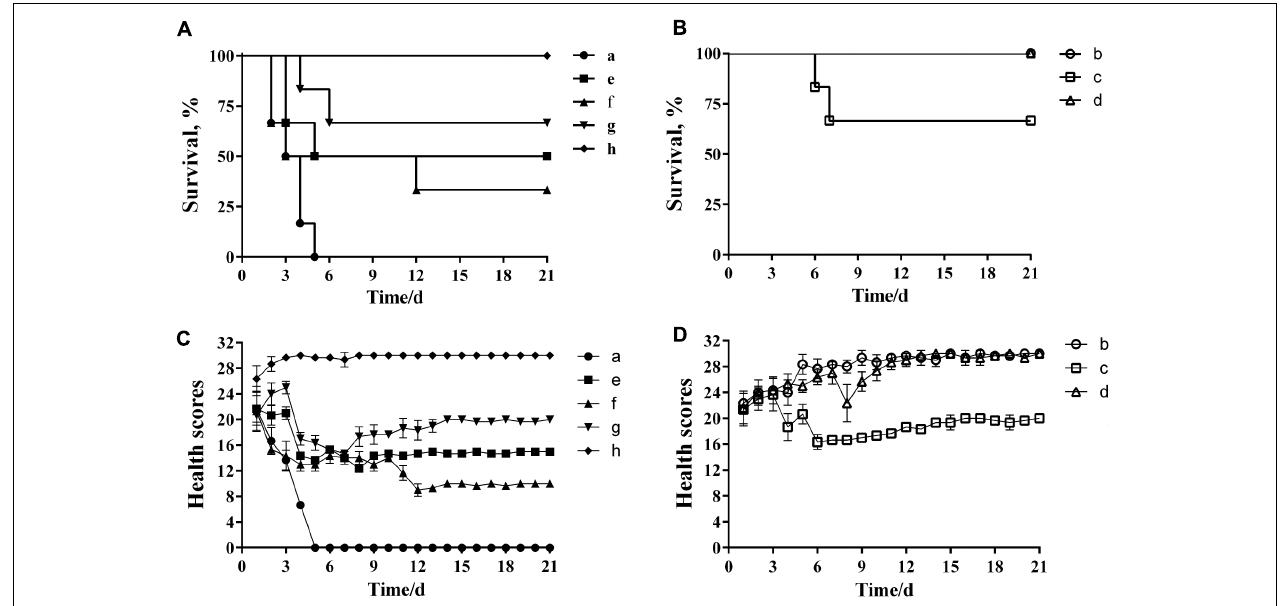
FIGURE 6 | Protective effects of depolymerase and phage in mice challenged with wild-type P. multocida strain HB03. (A) Treatment efficacy of purified recombinant depolymerase. (B) Treatment efficacy of phage PHB02. (C) Clinical symptom scores post-challenge with purified recombinant depolymerase. (D) Clinical symptom scores post-challenge with phage PHB02. Treatment groups were as follows: a, infected with P. multocida strain HB03; b, phage treatment 6 h post-infection; c, phage treatment 12 h post-infection; d, multiple-dose phage treatment 12 h post-infection; e, Dep-ORF8 treatment 6 h post-infection; f, Dep-ORF8 treatment 12 h post-infection; g, multiple-dose Dep-ORF8 treatment 12 h post-infection; h, inoculated with PBS only. The total score for the health status of each group was recorded at least three times per day. The data are expressed as the mean ±